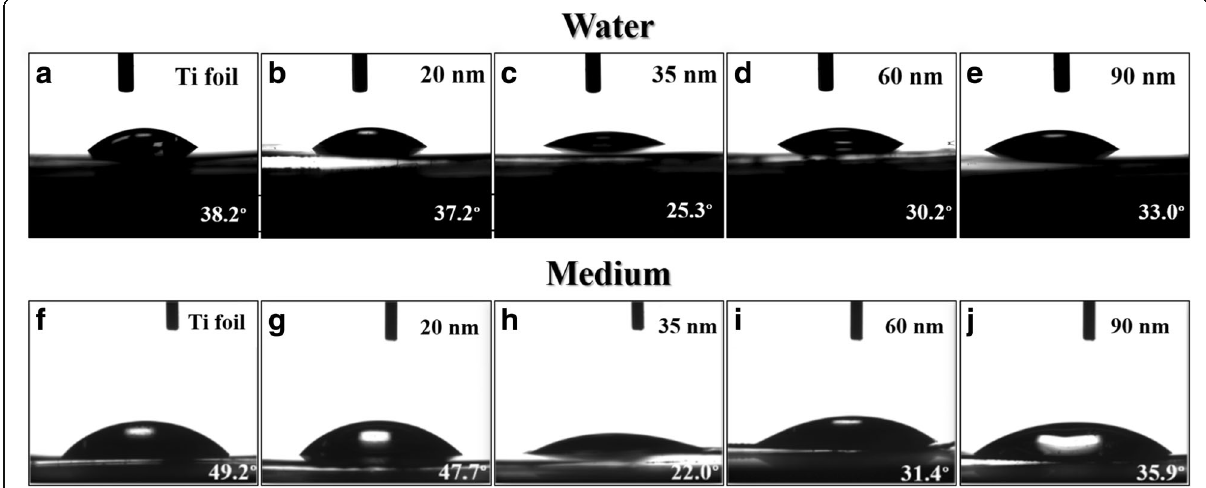
Fig. 4 a – j Optical images showing water and culture medium droplets on the a , f Ta foil surface and self-organized TaO x nanotubes with diame- ters of b , g 20, c , h 35, d,i 65, and e , j 90 nm, respectively. Contact angles are denoted in the